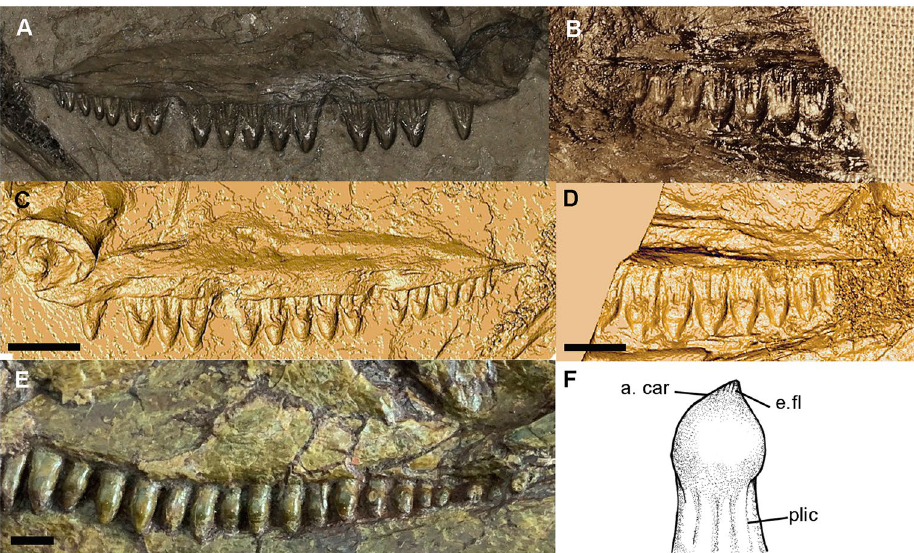
Figure 3. ( A , C ) Photograph and digital three-dimensional rendering of the maxilla of CM 93779. Digital render shows the positive relief and true anatomy of CM 93779 revealing 16 wide-based teeth with bulbous tips. ( B , D ) Photograph and digital three-dimensional rendering of the maxilla of CM 93778. Digital render shows the positive relief and true anatomy of the medial surface of the maxilla on CM 93778, revealing the bulbous tooth tips from a different perspective. ( E ) Maxilla of a specimen of Edaphosaurus sp. (USNM PAL 299844), showing teeth with bulbous crowns with nozzle-like apices. ( F ) Reconstruction of a tooth of